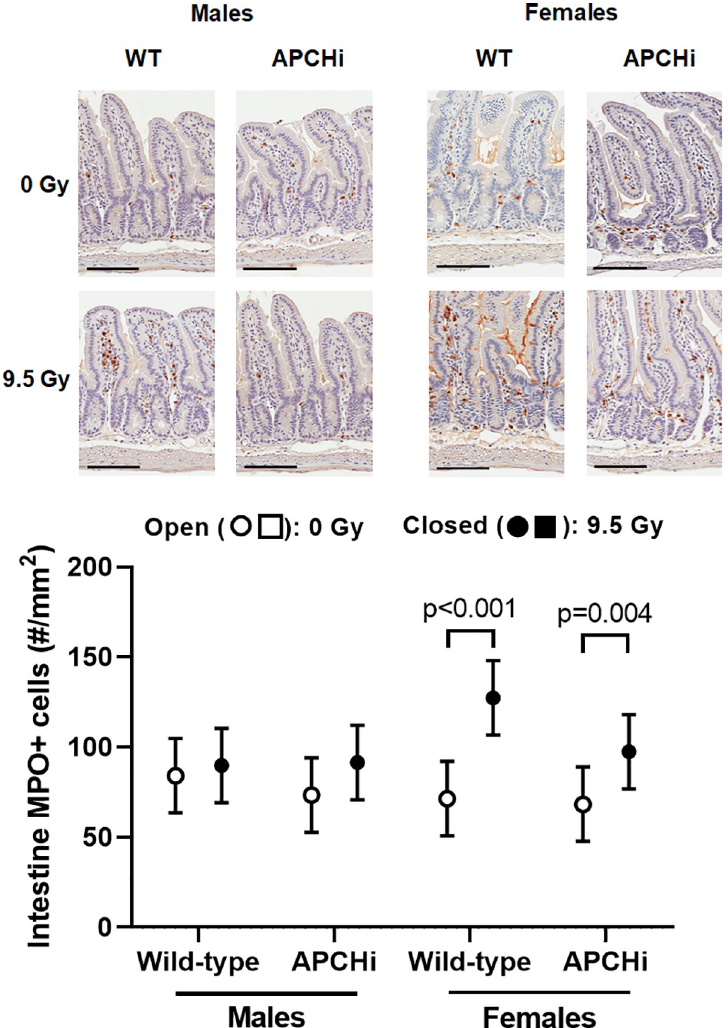
means and SD of the statistical model; n = 7 wild-type males in 0 Gy, 12 wild-type males in 9.5 Gy, 8 APCHi males in 0 Gy, 10 APCHi males in 9.5 Gy, 8 wild-type females in 0 Gy, 5 wild-type females in 9.5 Gy, 10 APCHi females in 0 Gy, and 8 APCHi females in 9.5 Gy. Brackets indicate significant differences between 0 Gy and 9.5